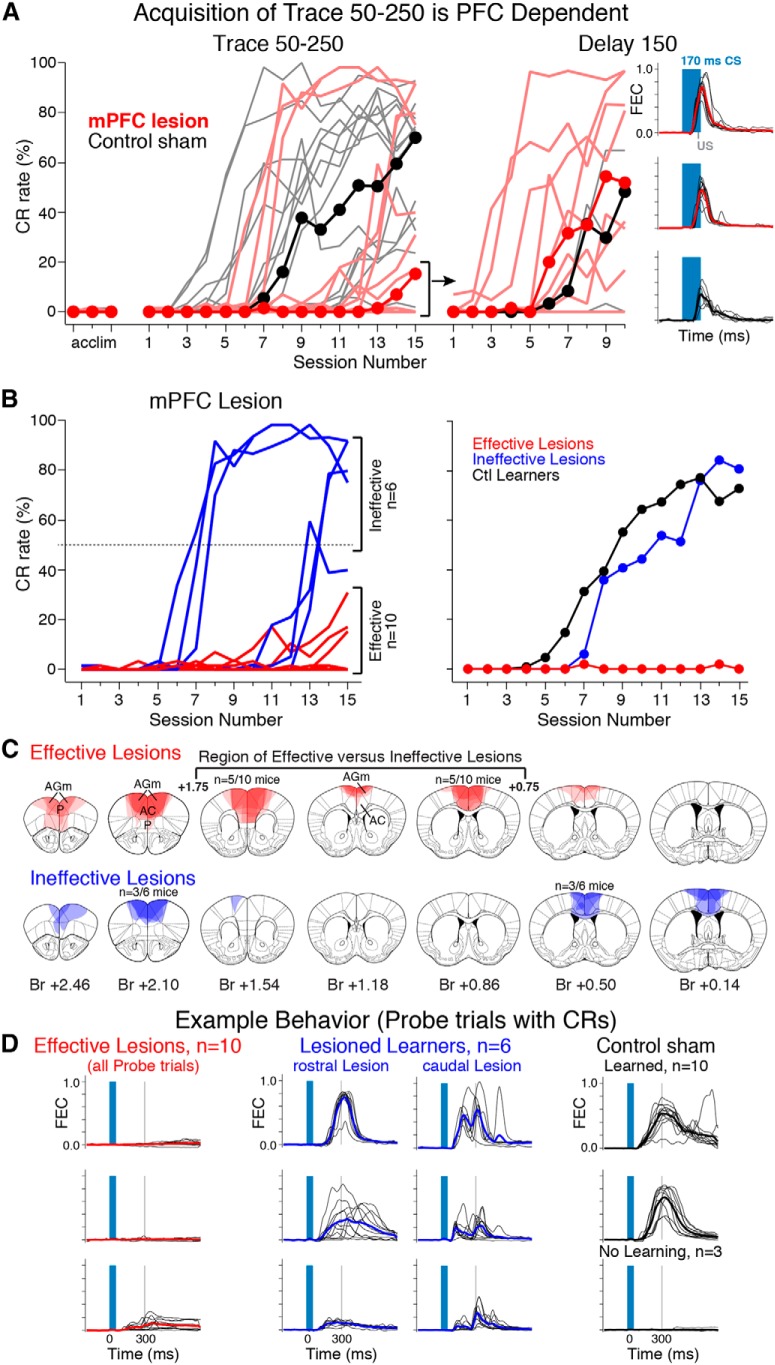
Acquisition of trace 50–250 is dependent on a subregion of mPFC in mice. A, CR rates during acclimation and training sessions (left graph) in mPFC-lesioned (light red lines) and sham-operated control mice (light black lines). Black and red markers show median CR rates observed each session for control and lesioned mice, respectively. Note that although a subset of lesioned mice learned, the median value indicates that most lesioned mice showed few if any CRs after 15 training days. Most lesioned nonlearners were able to acquire normal CRs for a non-mPFC-dependent delay eyeblink-conditioning task, showing that the deficit was specific to trace conditioning and did not reflect a global learning impairment in these mice (right graph, example behavior from 2 lesioned and 1 control mice are shown, denoted by red and black lines, respectively). B, CR rates for all lesioned mice, color-coded as lesioned nonlearners (red lines; Effective) and lesioned learners (blue lines; Ineffective). Median CR rates between control mice (right graph, black markers) and mice with ineffective mPFC lesions (blue markers) were similar, in contrast to mice that did not learn the task (red markers). C, Lesion reconstructions for all mPFC lesioned mice, separated into Effective (red, top row; n = 10) and Ineffective (blue, bottom row; n = 6) mice (opacity was adjusted for each mouse such that the total number of mice = 100%). Note that mice with damage to at least 500 µm of the medial agranular (AGm) and anterior cingulate (AC) between bregma +0.75–1.75 were not able to acquire the task (top, red shaded regions within bracketed sections), whereas mice with lesions that spared this area were able to learn (bottom). D, Example behavior from probe trials from effective lesions (red), ineffective lesioned learners (blue), and control mice (black). Most lesioned mice showed no learning (red, top 2 graphs). One lesioned mouse that showed some learning but did not meet criterion is also shown (red, bottom graph). Mice with lesions restricted to the most rostral mPFC (anterior to bregma +1.75) showed normal learning (blue, middle left graphs), whereas lesions restricted to the most caudal mPFC (posterior to bregma +0.75) showed abnormal CRs with uncharacteristic double-peaked responses (blue, middle right graphs) relative to control mice (black, right graphs). One example from a control mouse that did not learn is also shown (bottom right graph). Br, Bregma; AGm, medial agranular cortex; P, prelimbic cortex; AC, anterior cingulate cortex.